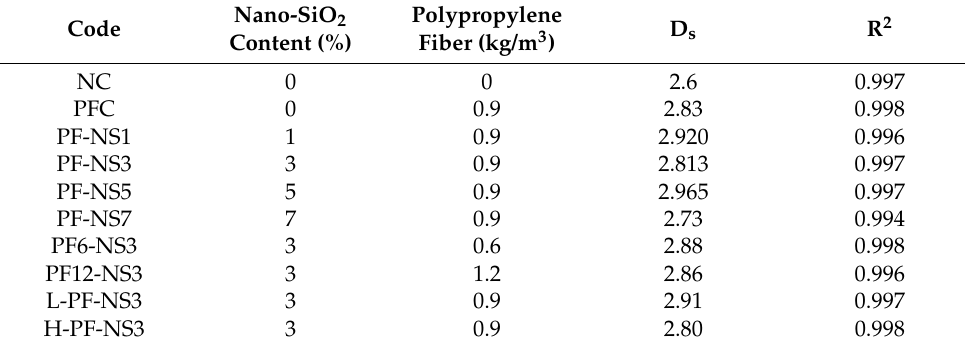
Table 5. Fractal dimension of selected